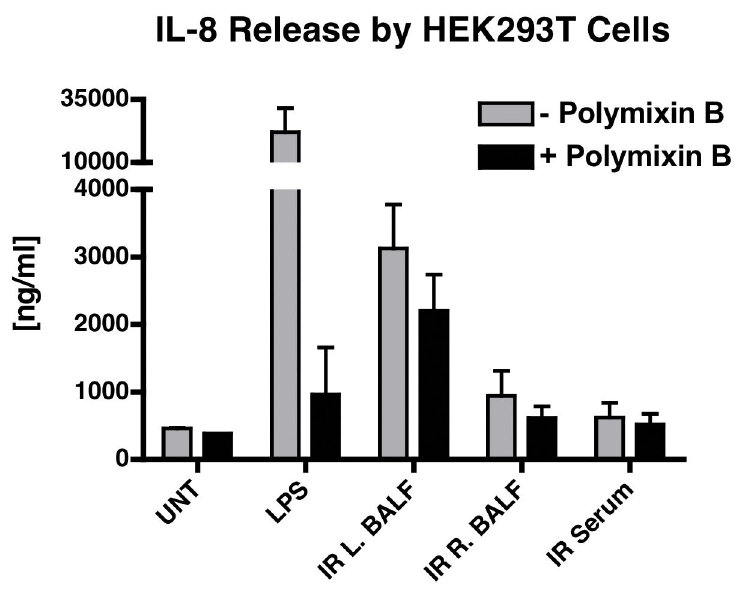
Figure 6. IL-8 release by HEK293T cells expressing murine TLR4, CD14, and MD2. Cells were stimulated with serum, right lung BAL fluid, or left lung BAL fluid collected from mice subjected to 1 hr of left lung ischemia followed by 4 hr of reperfusion. Cells were treated with medium only for a negative control or with LPS (10 ng/ml) for a positive control. Each experiment was carried out with and without polymixin B (50 µg/ml).